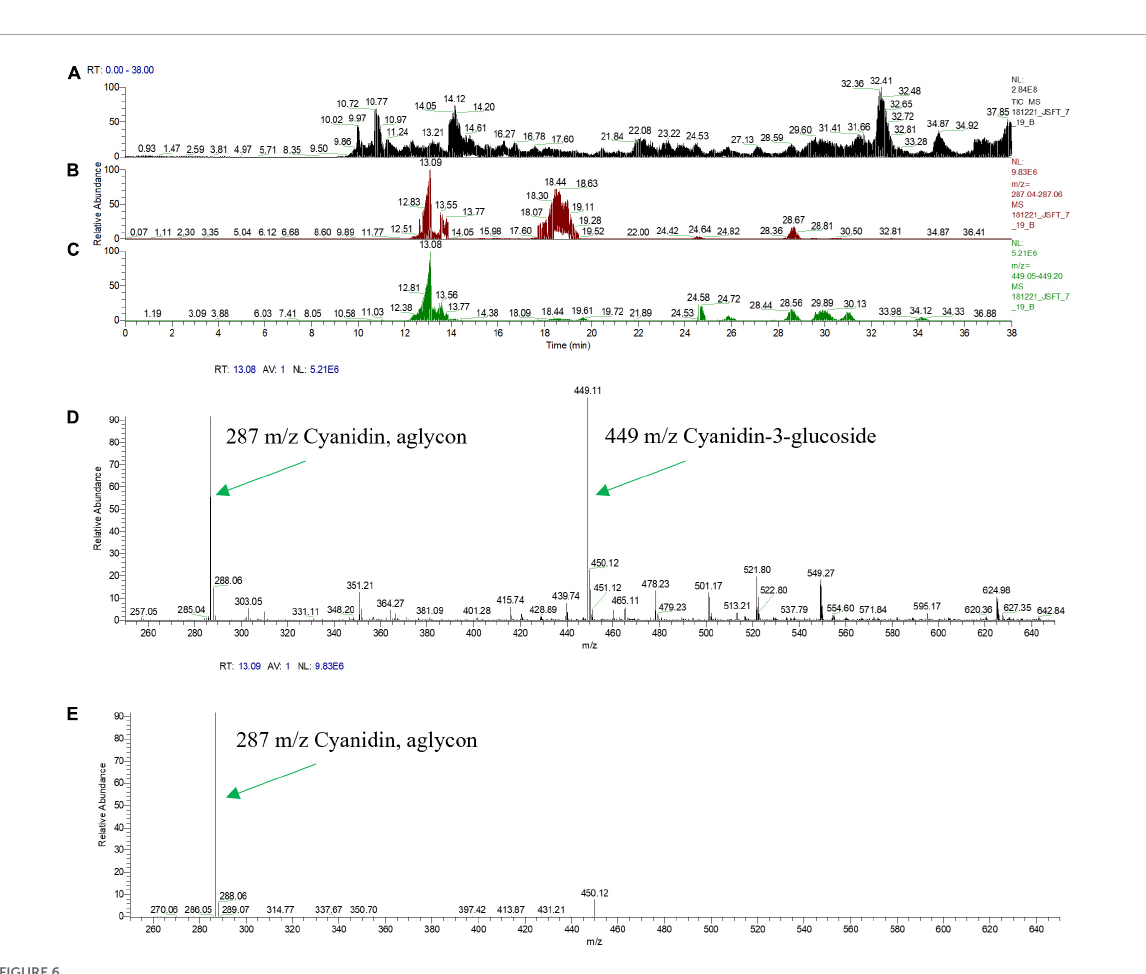
FIGURE6 Mass Spectral Analysis (HPLC-MS-MS) profiles of fresh squeezed juice of line CitWax 7-19. (A) Top panel shows the ion capture of all charge in compounds from MS survey scan range of 200–2,000 m/z. (B) Second panel shows specific ion capture from 287.04 to 287.06 m/z. (C) Third panel shown specific ion capture from 449.05 to 449.20 m/z. (D) Forth panel shows the strongest specific peaks from the full MS1 survey scan range of 200–2,000 m/z at the retention time of 13.08 min. (E) Fifth panel shows MS2 of 449.11 m/z at retention time